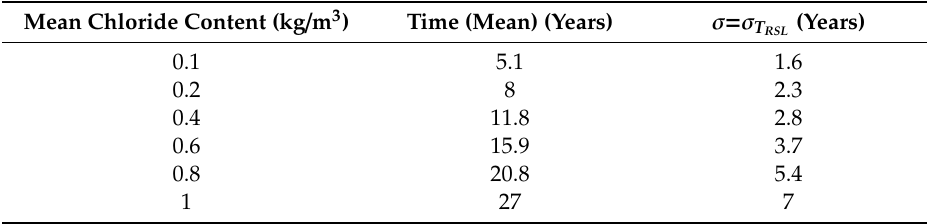
) with time (predictions at t = 2 years ). insp RSL